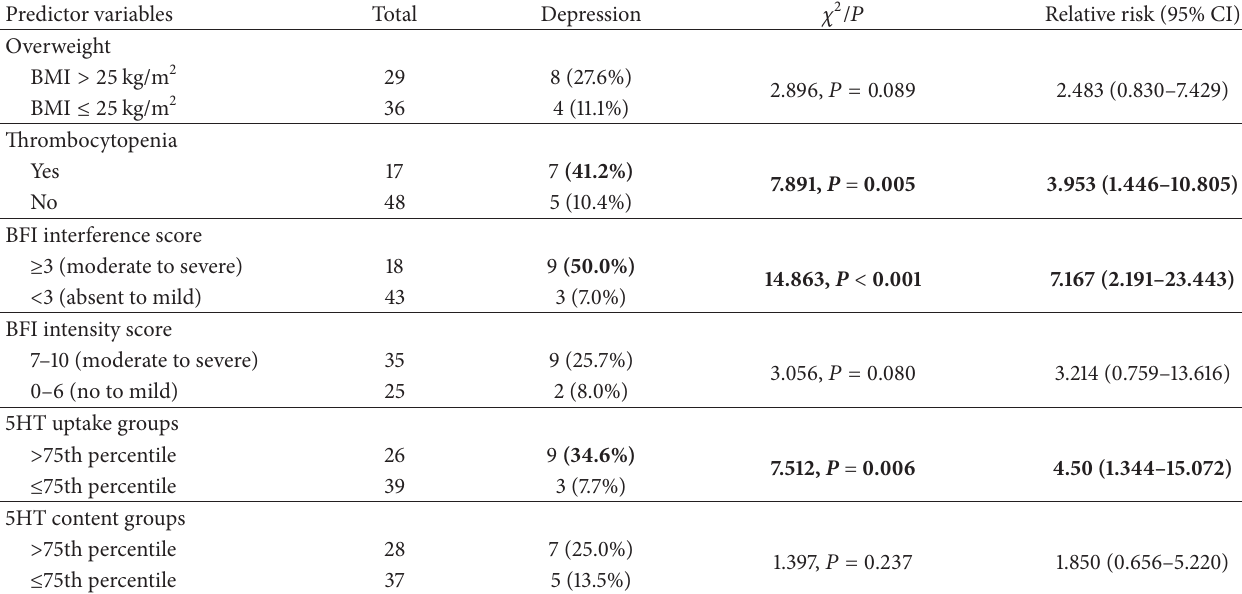
Table 4: Chi-Square Test of association between the predictor variables and the likelihood of depression. Predictor